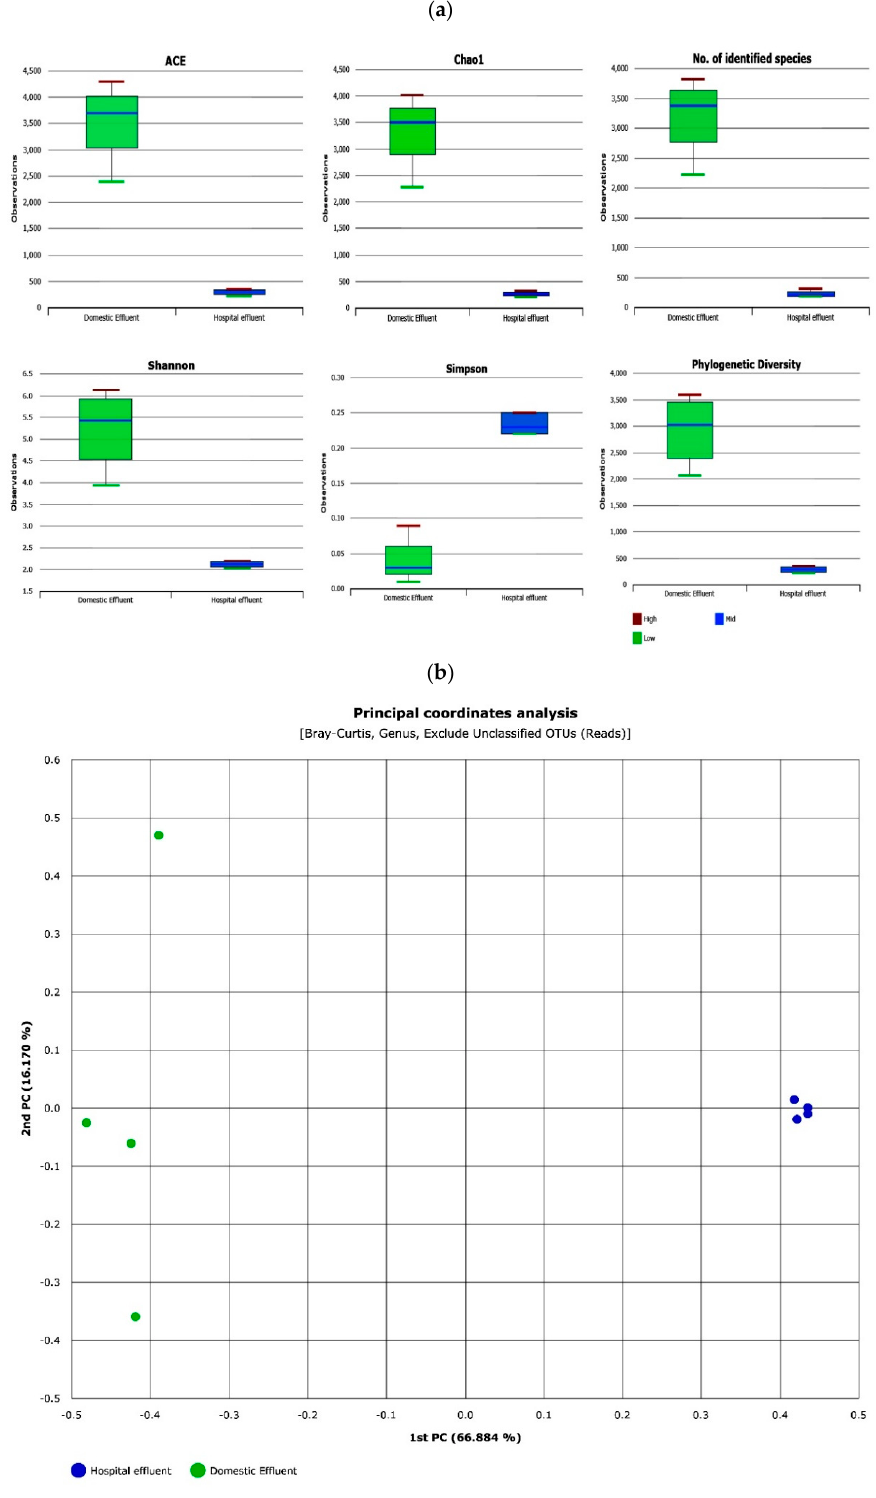
Figure 2. Diversity indices of hospital and domestic wastewater samples ( a ) Box-plots representing the Alpha diversity indices—ACE, Chao1, Shannon and Simpson. Median values (horizontal line) and interquartile ranges have been depicted in the plots. ( b ) Principal coordinate analysis (PCoA) based on Bray–Curtis dissimilarities grouped by effluent samples. High-throughput sequencing analysis showed that the bacterial communities in the DWW were distributed among five major bacterial phyla. Of these, the phylum